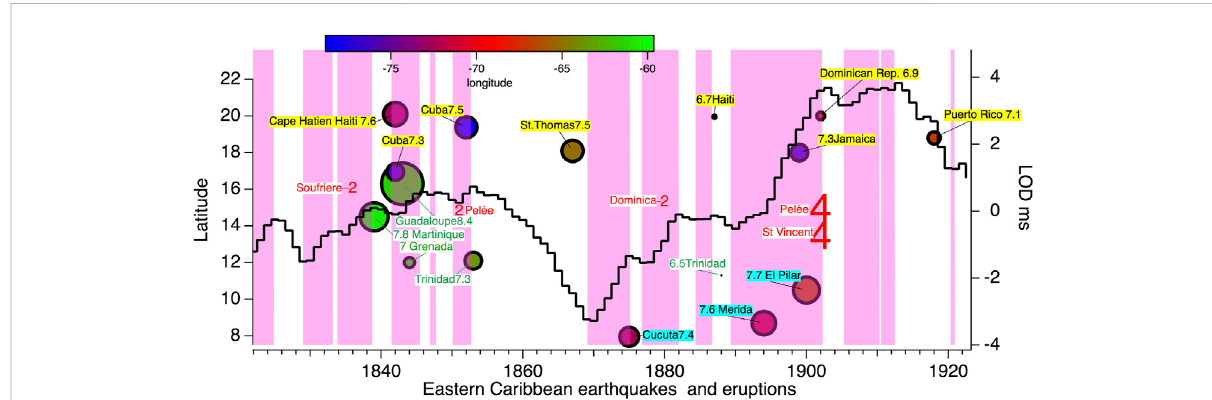
FIGURE 9 Time/space plot of Eastern Caribbean seismicity (circles 6.8 < Mw < 7.7) and volcanism (red numbers VEI 2 – 4), compared to length of day (LOD = black cityscape line). The color coding is according to longitude (top panel) and circle sizes are proportional to magnitude. Violet shading indicates periods of deceleration, yellow highlight = earthquakes on northern transform, blue highlight = earthquakes on southern transform, green script=easternsubductionearthquakes,redscript=namederuptions.Longitudes < 65 ° Wincludesubductionvolcanismandearthquakesinthe eastern Caribbean. The plot illustrates the extreme (7 ms) increase in the LOD that occurred between 1870 and 1910, during which seismicity on the Bocono fault system was prominent, and northern seismicity largely